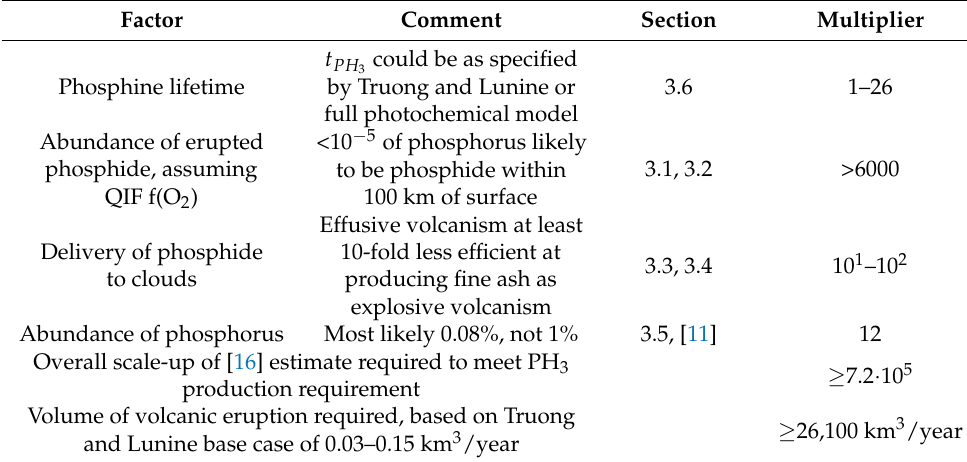
Table 2. Summary of factors required for Truong and Lunine [16] base